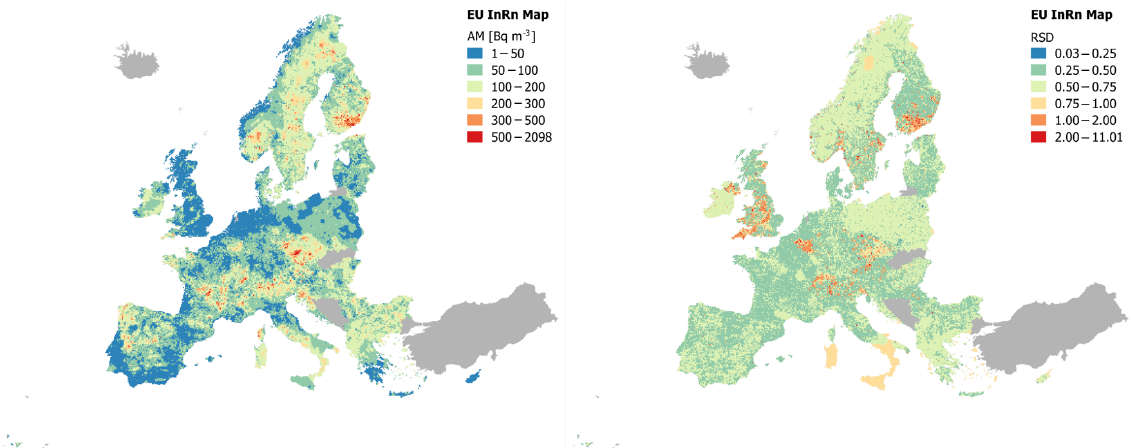
Figure 12. Final Pan-European Indoor Radon